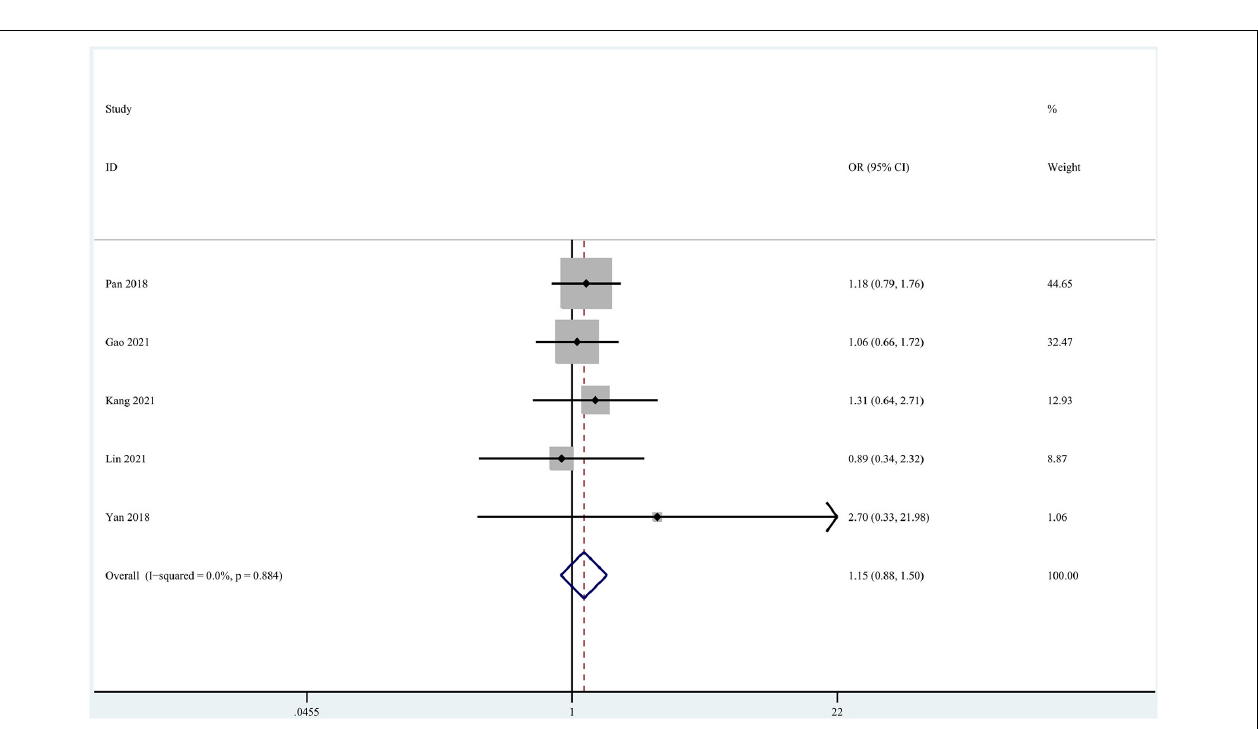
FIGURE 7 | Forest plot of the accuracy in the pMCI vs. sMCI classification task.